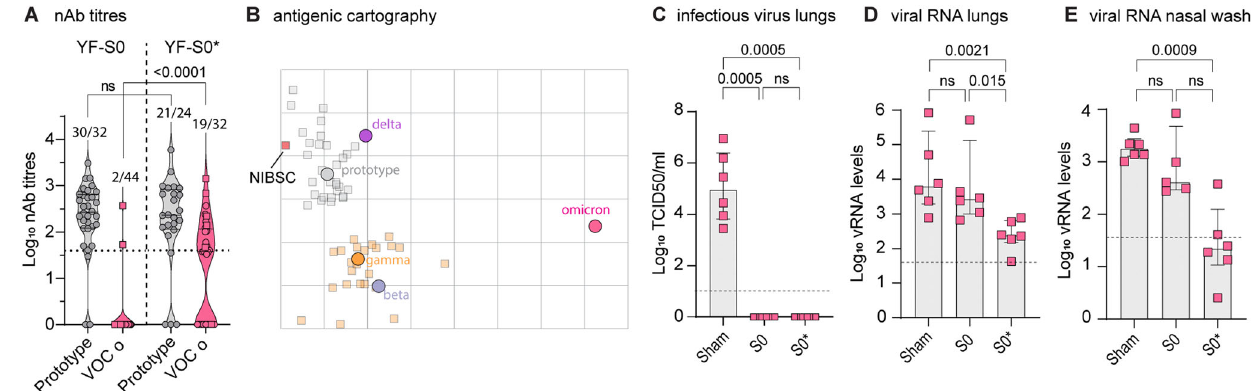
Fig.4|IncreasedpotencyofvaccinecandidateS0*againstVOCOmicron.A nAb titres against prototypic and omicron spike-pseudotyped virus on day 28 after vaccination with two doses (day 0 and day 7) of prototype YF-S0 or YF-S0*. NAb titresagainstprototypicspike-pseudotypedvirus(graycircles)arefromFig.2Aand D. Same sera were retested for Omicron spike-pseudotype virus (pink symbols). Red squares denote nAb titers for those animals included in the subsequent chal- lenge study (see also Fig. S1). B Antigenic cartography. Cross-reactivity of sera raised by original S0 (gray squares) and updated S0* (orange squares) vaccine antigen against fi ve different SARS-COV-2 variants (circles: prototype, gray; VOC Beta, blue; Gamma, orange; Delta, purple; Omicron, pink) plotted on a